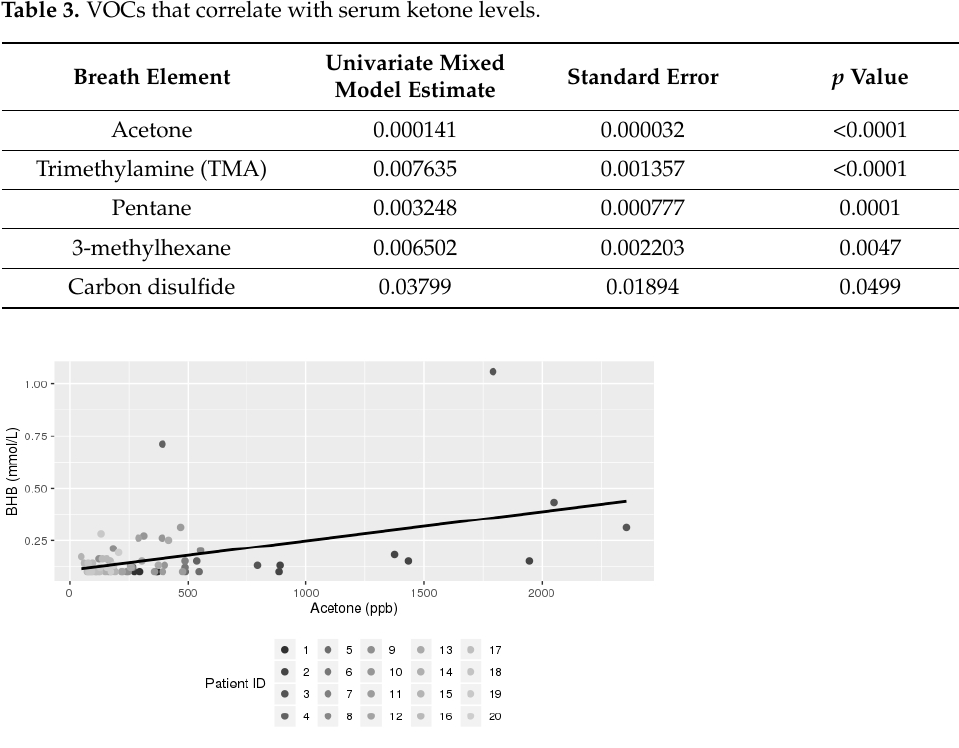
Figure 1. Scatter plot for breath acetone vs. serum ketones (BHB). Dots with the same color shade belong to the same patient.